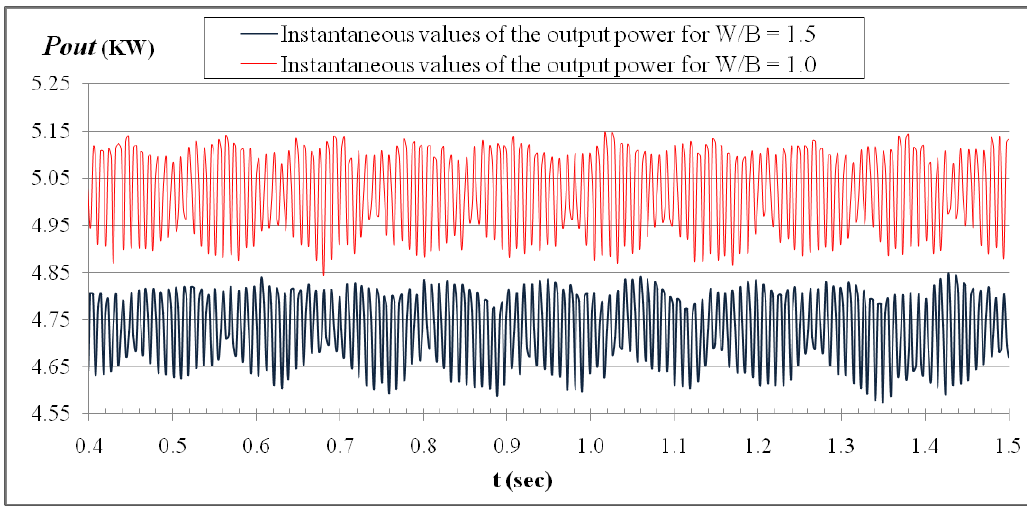
of the turbine for two out